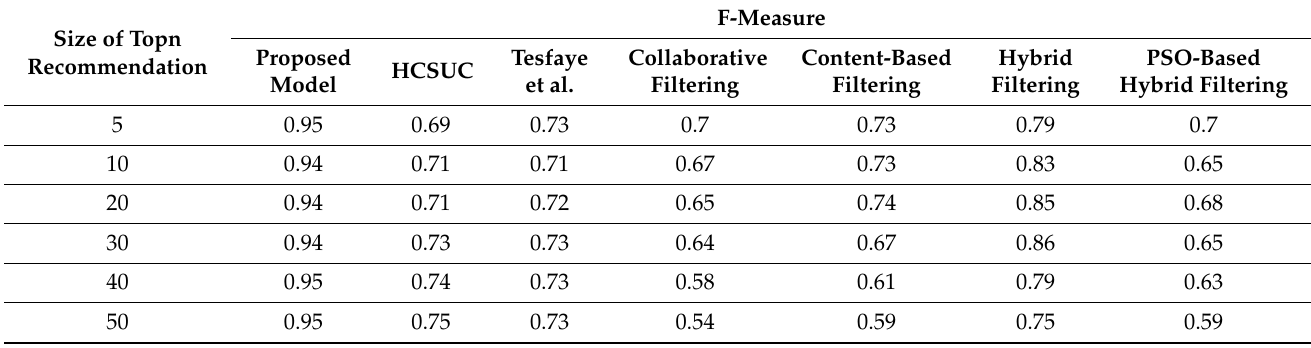
Table 13. F-Measure according to the Topn Recommendation (Considering Dataset 3 [45]).